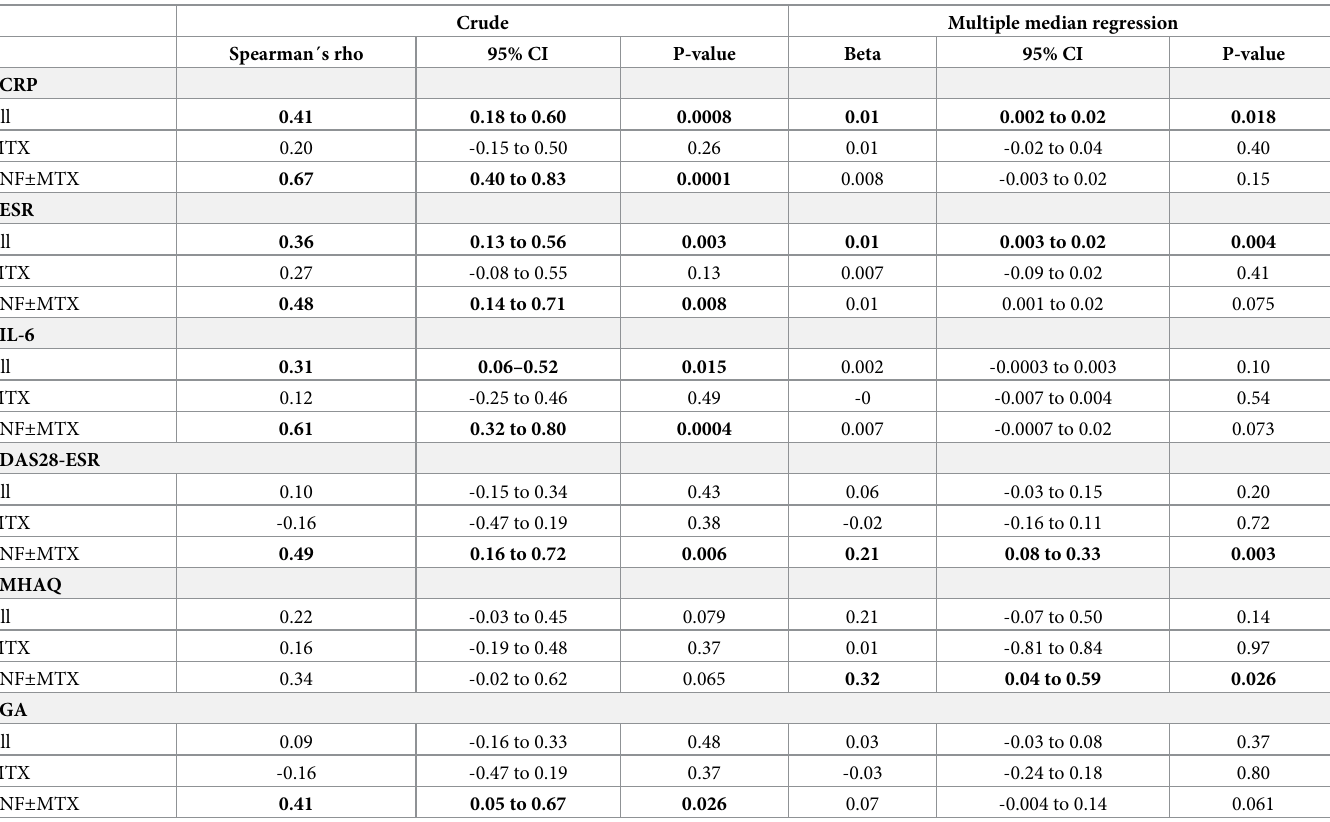
Table 5. Associations between changes in TCC and changes in selected markers of arthritis activity after 6 weeks of treatment.